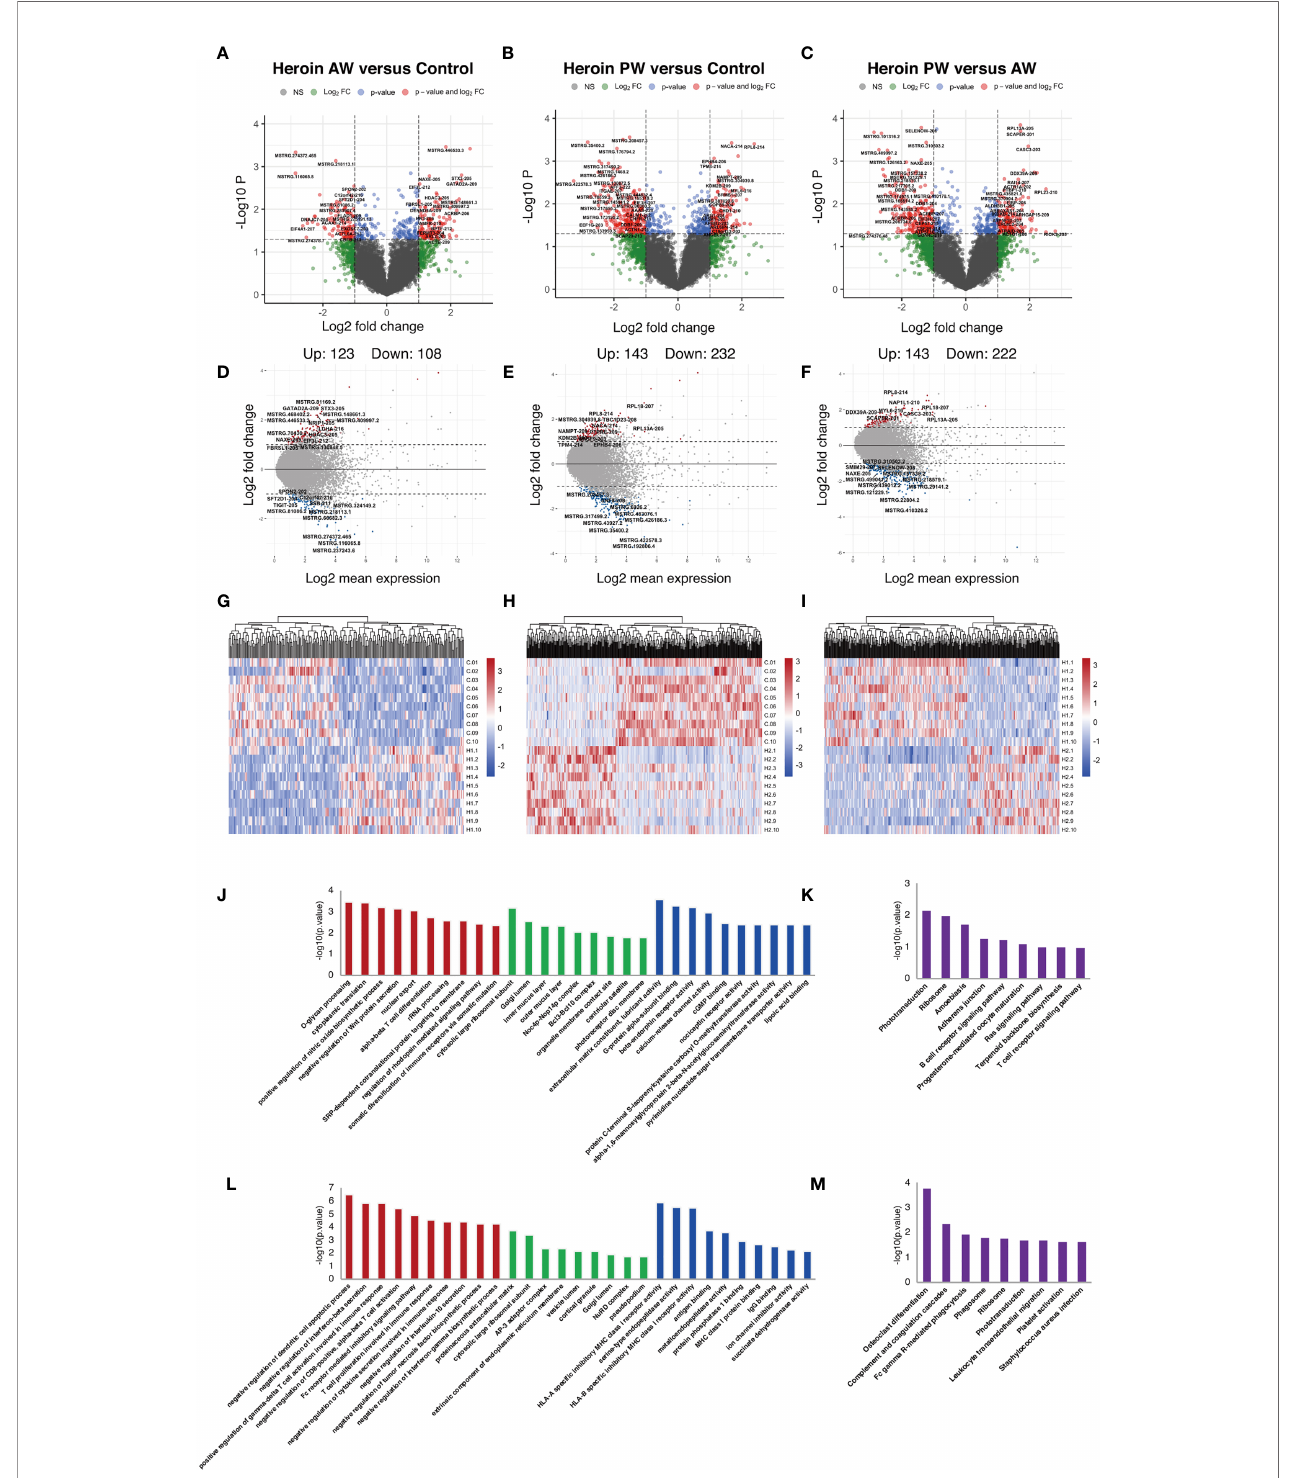
FIGURE 3 | Identi fi cation and functional enrichment analysis of differentially expressed exosome lncRNAs. (A, D, G) The volcano plot and MA plot (A, D) and hierarchical clustering heatmap (G) of differentially expressed exosome lncRNAs in Heroin AW versus HC (P < 0.05, fold change > 1.5). (B, E, H) The volcano plot and MA plot (B, E) and hierarchical clustering heatmap (H) of differentially expressed exosome lncRNAs in Heroin PW versus HC (P < 0.05, fold change > 1.5). (C, F, I) The volcano plot and MA plot (C, F) and hierarchical clustering heatmap (I) of differentially expressed exosome lncRNAs in Heroin AW versus Heroin PW (P < 0.05, fold change > 1.5). (J, M) Top enrichment of KEGG pathways related to differentially expressed exosome lncRNAs in Heroin AW versus HC (J, K) and in Heroin PW versus HC (L, M)